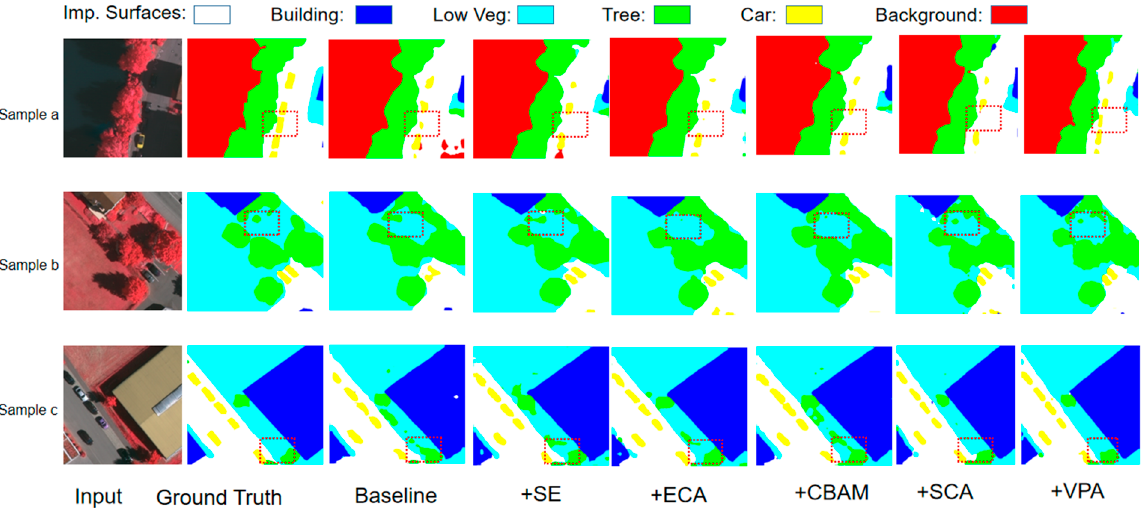
mark the more obvious di ff erences.